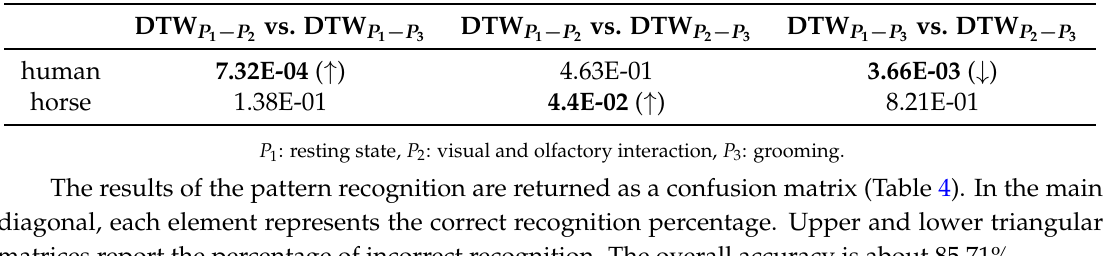
Table 3. p -Values related to pairwise statistical analysis of DTW values, as estimated within each enrolled subject, during the different phases ( P 1 , P 2 , P 3 ).